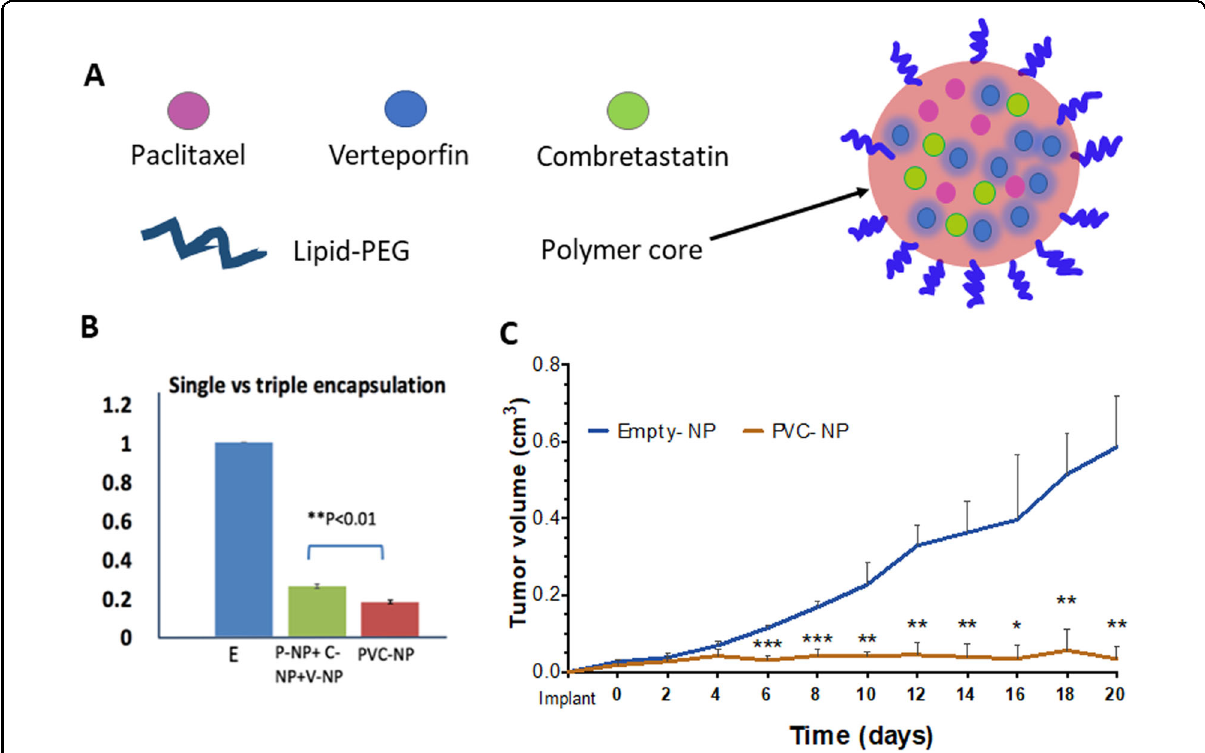
Fig. 6 Triple drugs co-encapsulated in one NP stopped TNBC PDX tumor growth in vivo. A Schematic showing the development of a triple- drug NP system co-encapsulating CA4, paclitaxel, and vertepor fi n. B Viability analysis using an MTT assay after 120-hr treatment with empty-NP (E), paclitaxel-NP (P-NP) + vertepor fi n-NP (V-NP) + combretastatin-NP (C-NP), or PVC-NP at a 1:2:1 ratio. Drug-NPs were added at 0 and 72 hr. Three